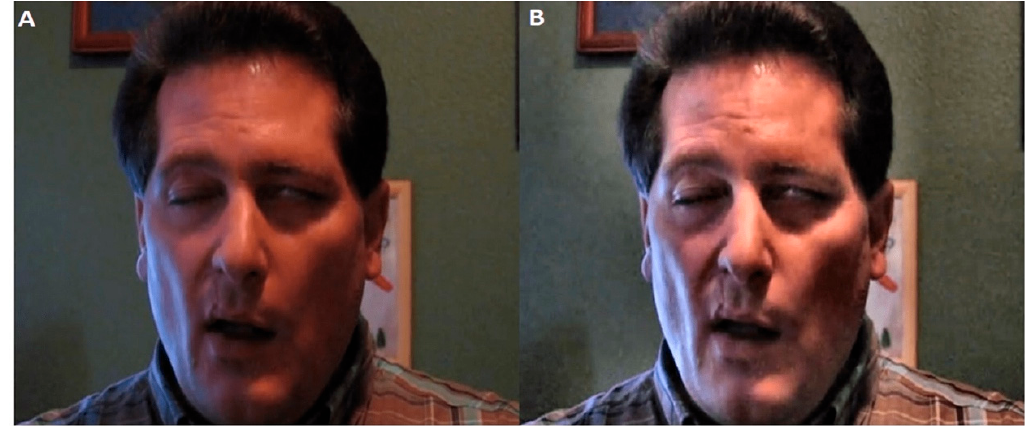
Figure 4. Example of contrast enhancement: ( A ) original image with a face and ( B ) contrast-enhanced image.